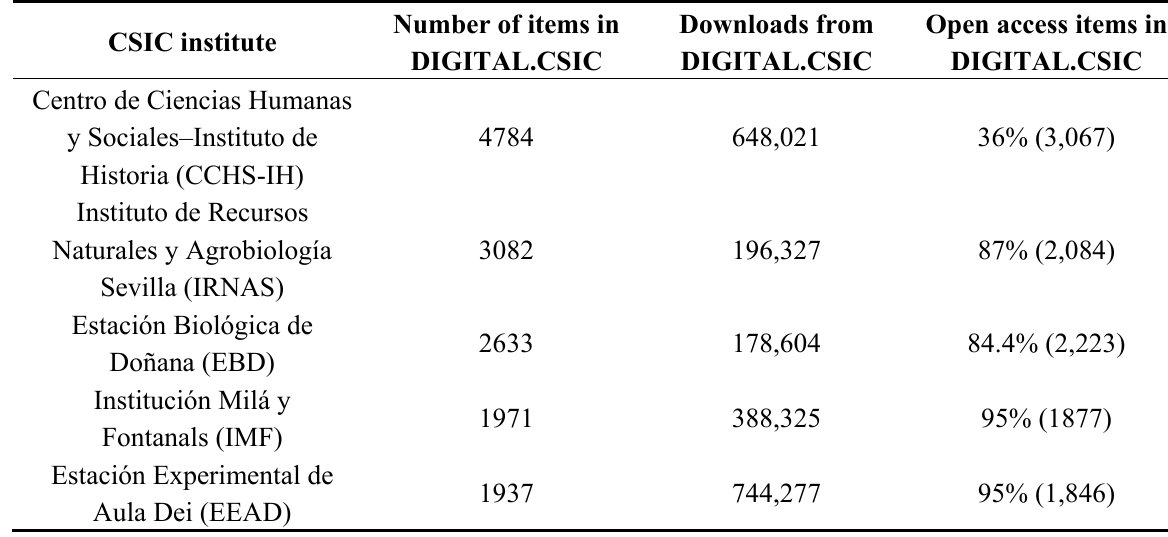
Table 2. Correlation between openness and full text downloads for CSIC institutes with the highest number of items at